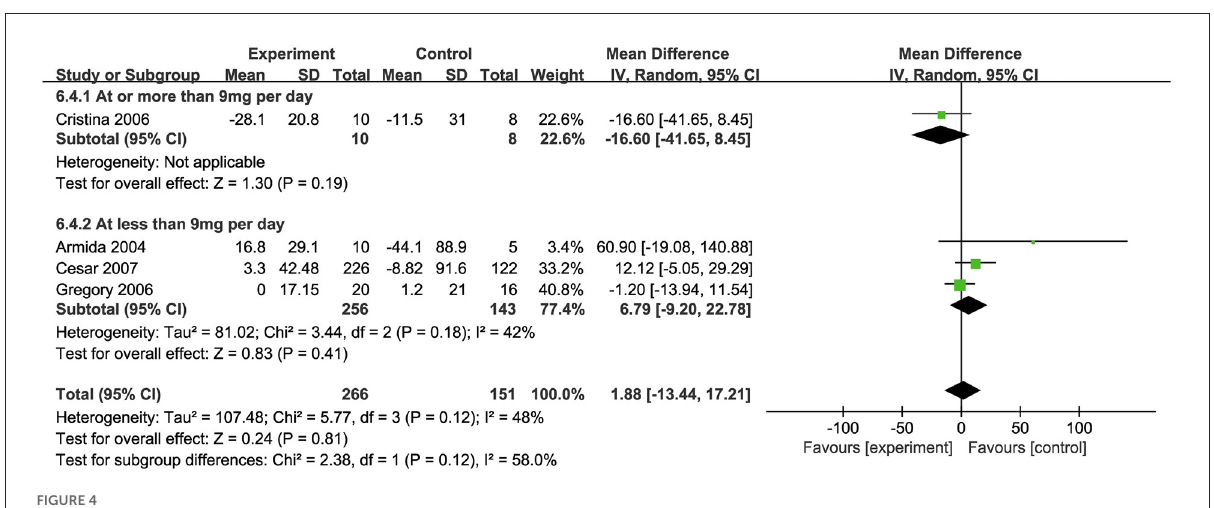
FIGURE4 Effects of biotin supplementation on insulin levels < or ≥ 9